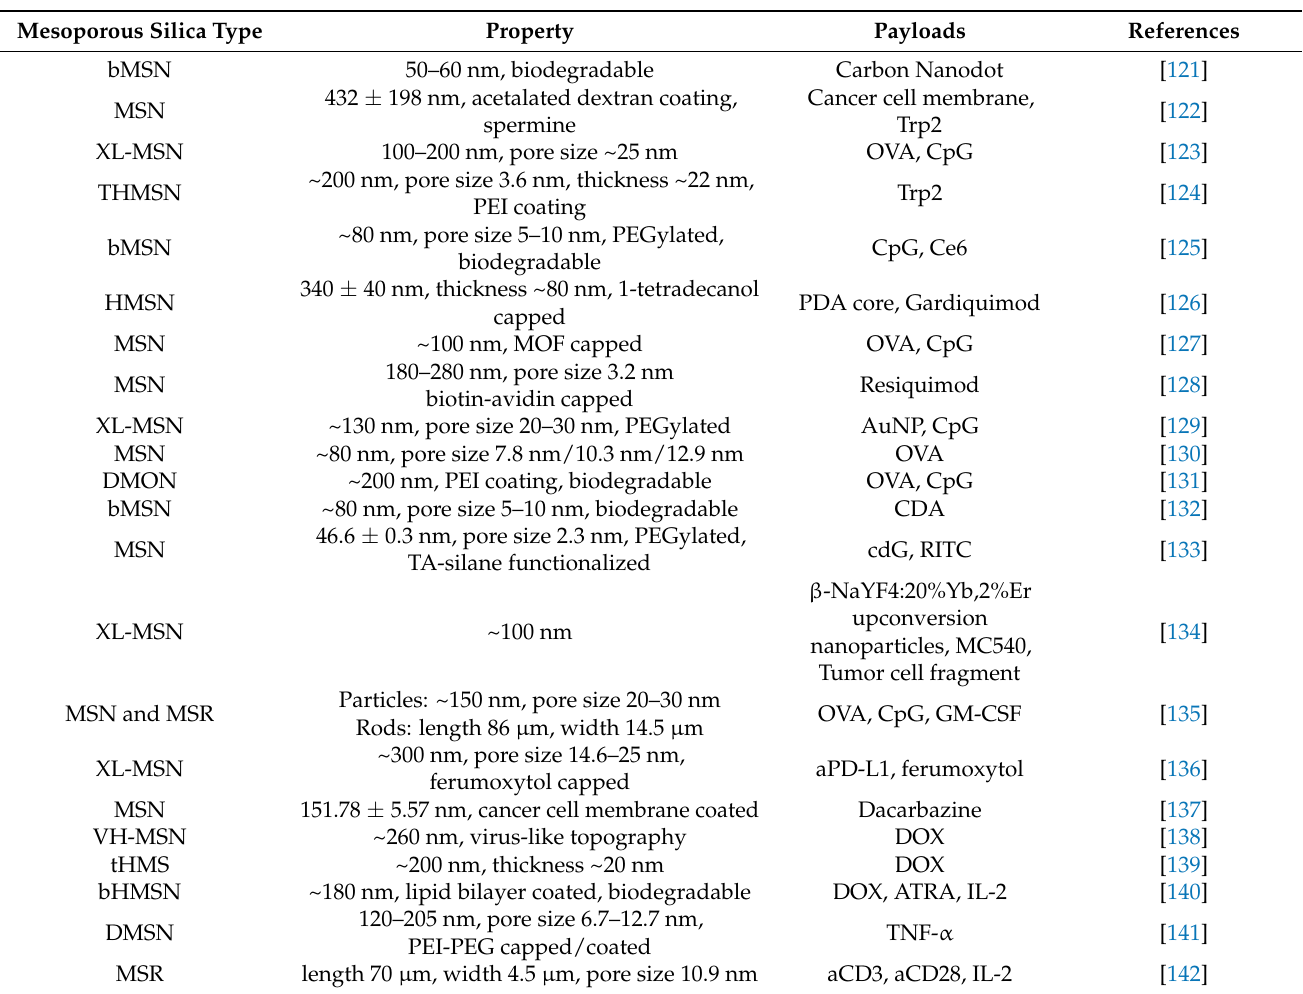
Table 3. Summary of recent works on mesoporous silica as a platform for cancer